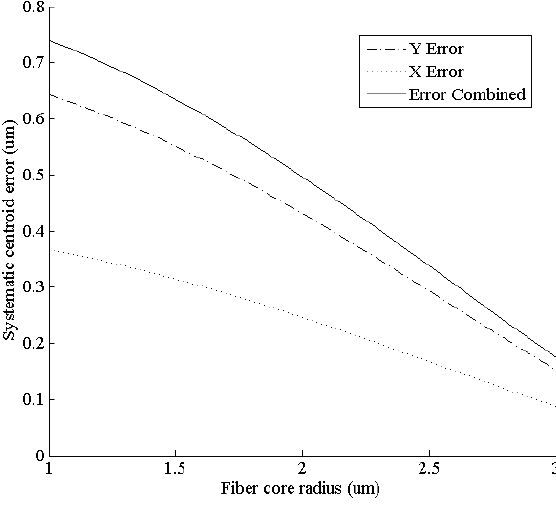
Figure 12. Systematic centroid error at (0.8 μ m, 1.4 μ m) under different fiber core radii. 6.3. Experimental Investigation on the Match between the Output FOFP of the Intensifier and the